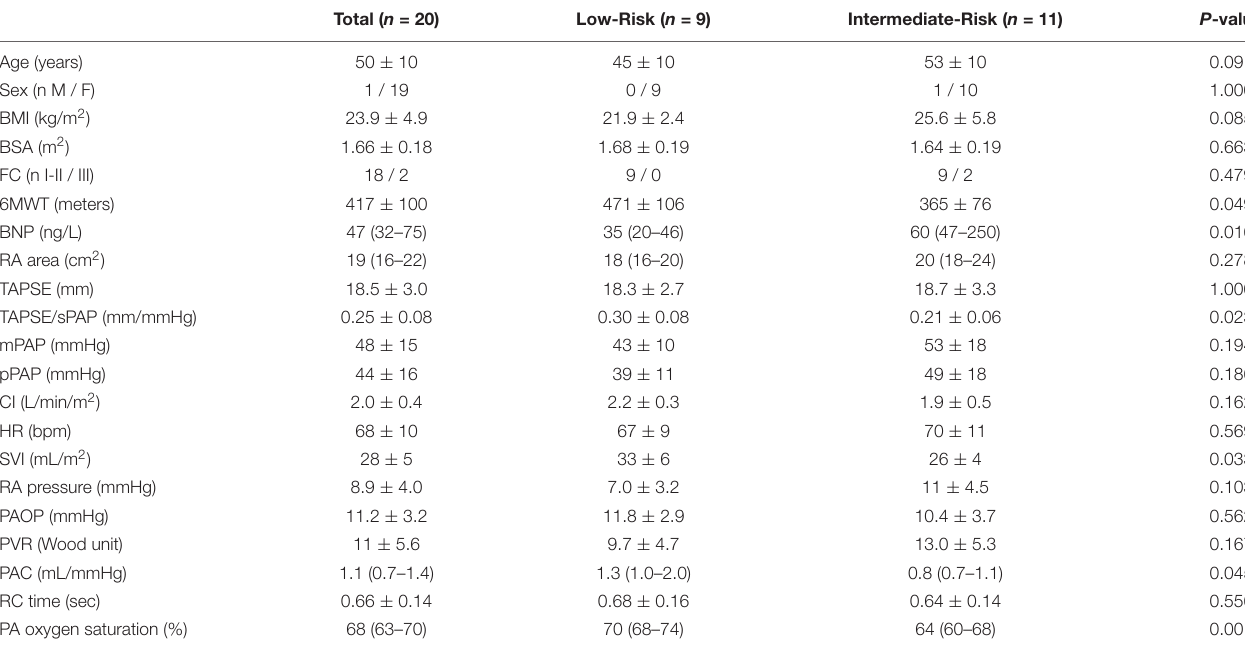
TABLE 2 | Summary of demographic, humoral, echocardiographic, and hemodynamic